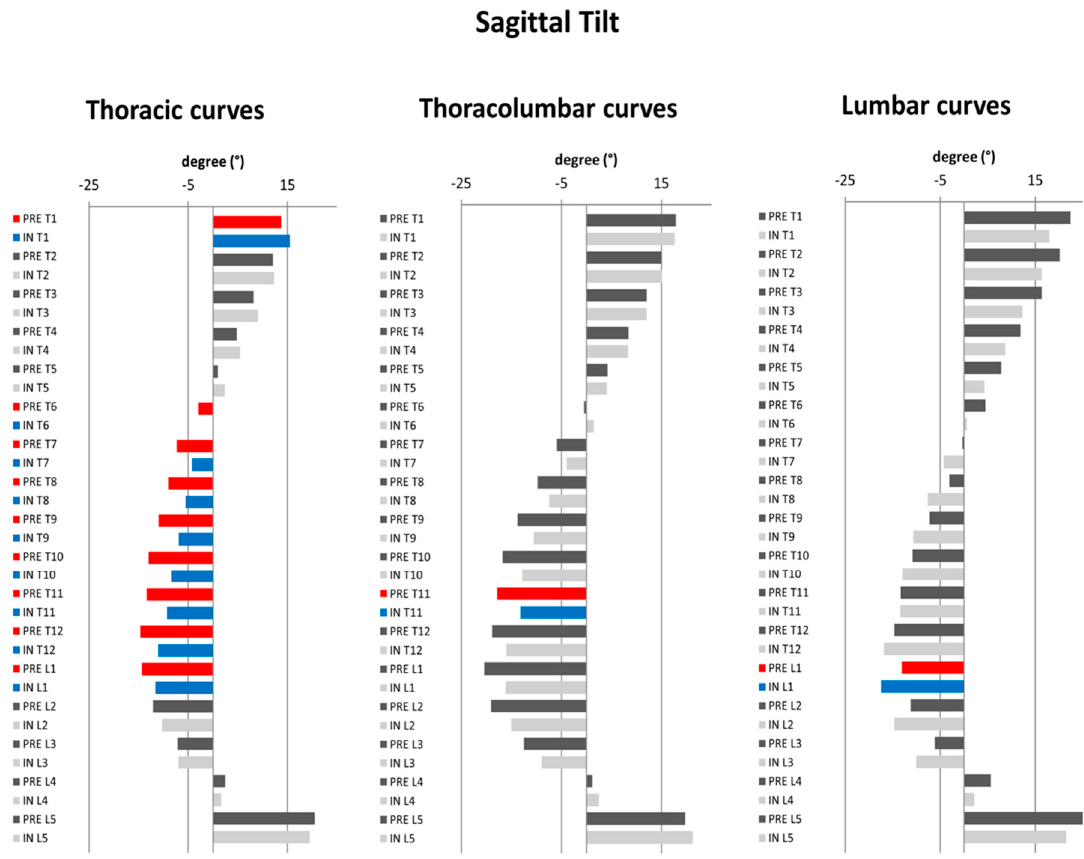
Figure 5. Diagrams illustrating the pre- to in-brace changes in vertebral sagittal tilt (T1–L5) pertaining to structural curve type. Dark grey: pre-brace, light grey: in-brace. Statistically significant changes in pre- to in-brace vertebral orientations are depicted in red (pre-brace) and blue (in-brace) ( p ≤ 0.05).